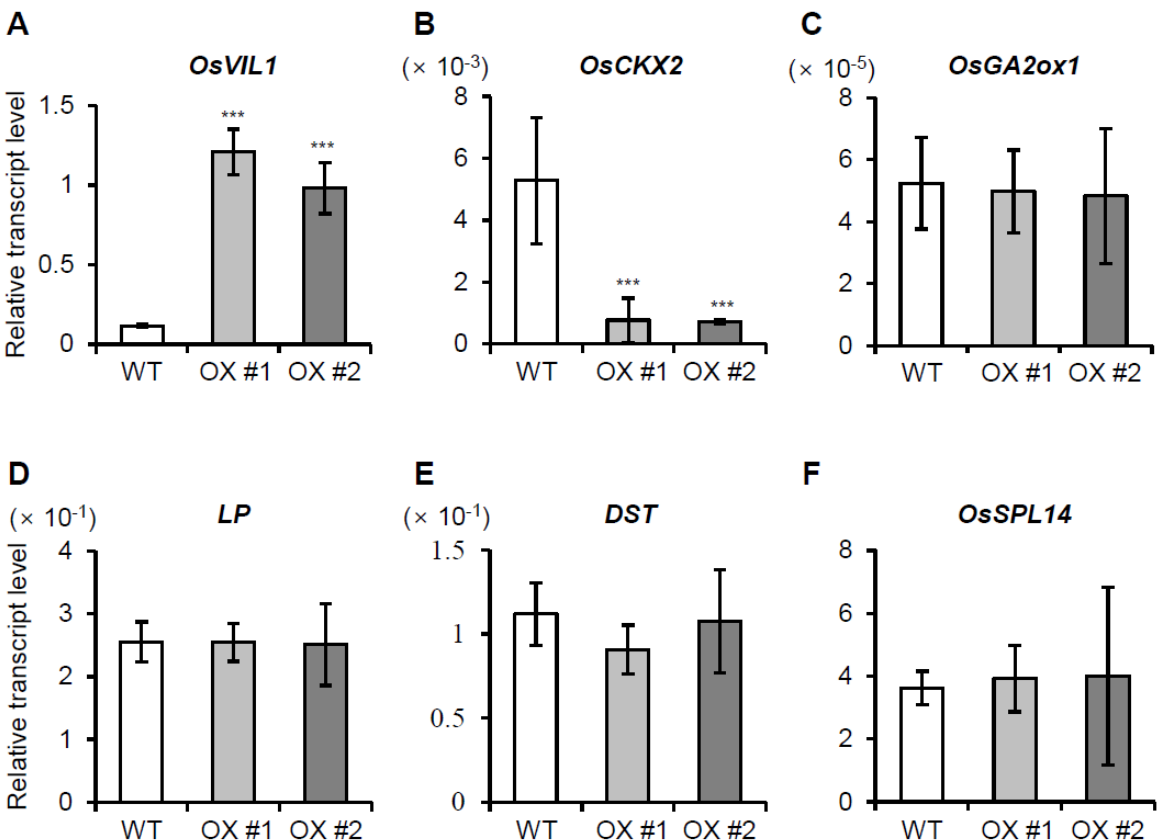
Figure 6. Expression levels of several genes regulating plant height and grain yield in OsVIL1 overexpression (OX) plants. Samples were prepared from the cell division zones (0.5 cm) of the first internodes (4 cm) under paddy field conditions. The expression levels of OsVIL1 ( A ), OsCKX2 ( B ), OsGA2ox1 ( C ), OsLP1 ( D ), OsDST ( E ), and OsSPL14 ( F ) in the first internode. Rice Ubiquitin1 was used as an internal control. The error bars indicate the standard deviations, n = Statistical significance is indicated by *** ( p < 0.001).